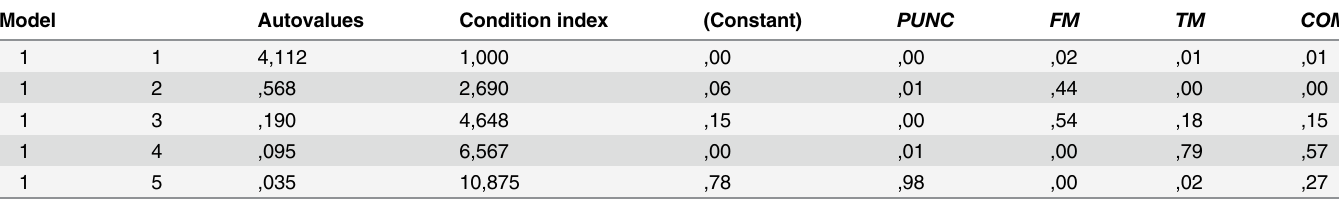
Table 6. Multicollineality